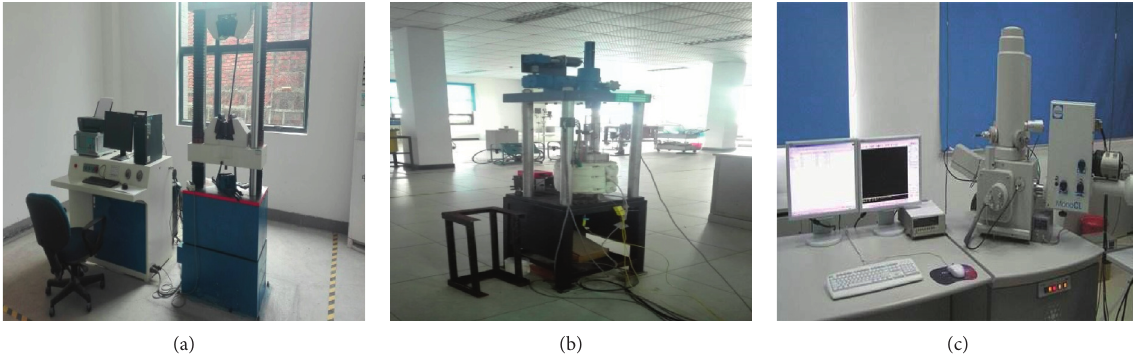
Figure 1: Instruments for stress corrosion experiment: (a) universal testing machine; (b) slow-strain-rate tensile testing machine; (c) scanning electron